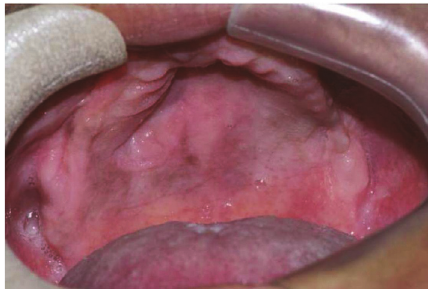
Figure 5: Clinical intraoral presentation after two months of chemo-radiotherapy